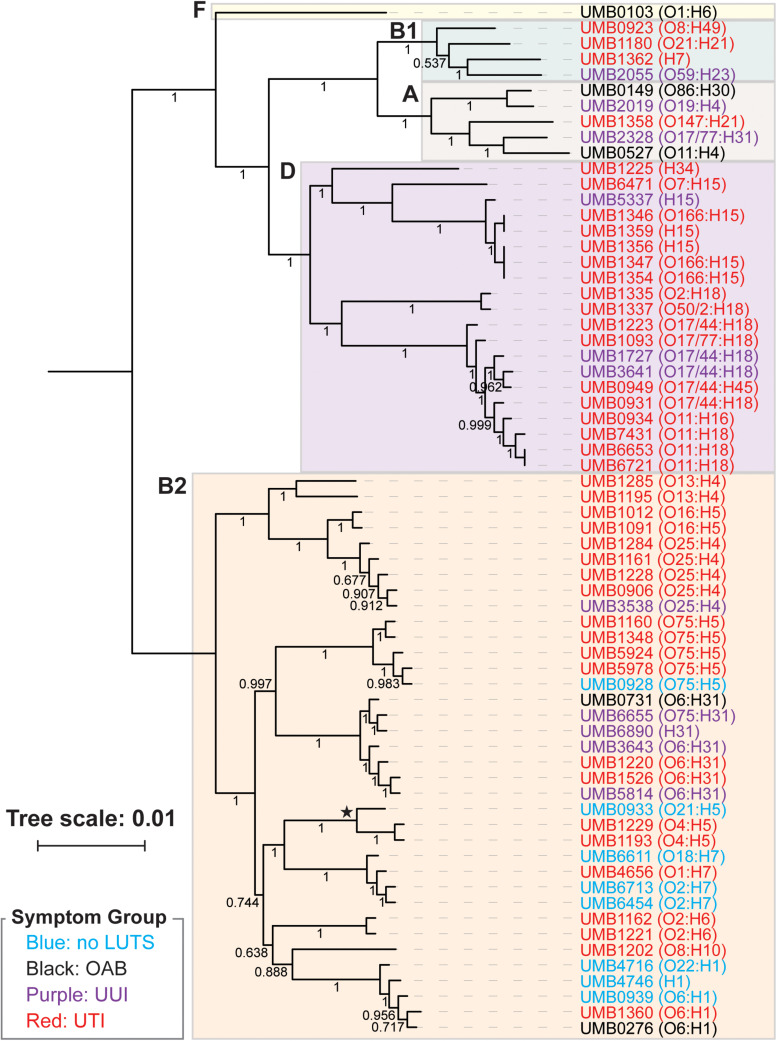
Phlyogenomic relationship of the 66 UTI (red) and non-UTI E. coli isolates from the bladder. Non-UTI symptom groups are indicated by color. Phylotypes are indicated by the colored boxes. The branch labeled with a star indicates the 3 isolates of the subphylotype B22. Serotypes for each isolate are listed next to the isolate name. Branch supports are shown.